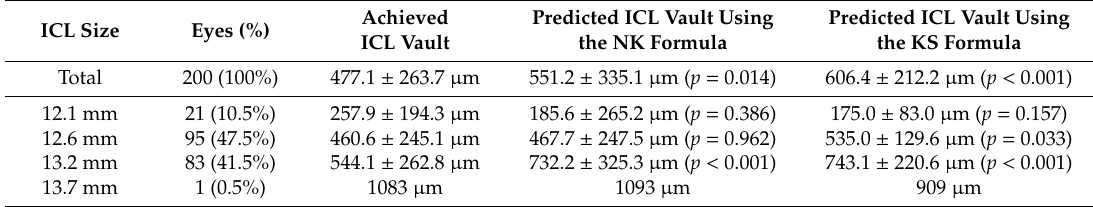
Table 2. The achieved ICL vault using the manufacturer’s nomogram and the predicted ICL vault by the NK and KS formulas according to the selected ICL size.